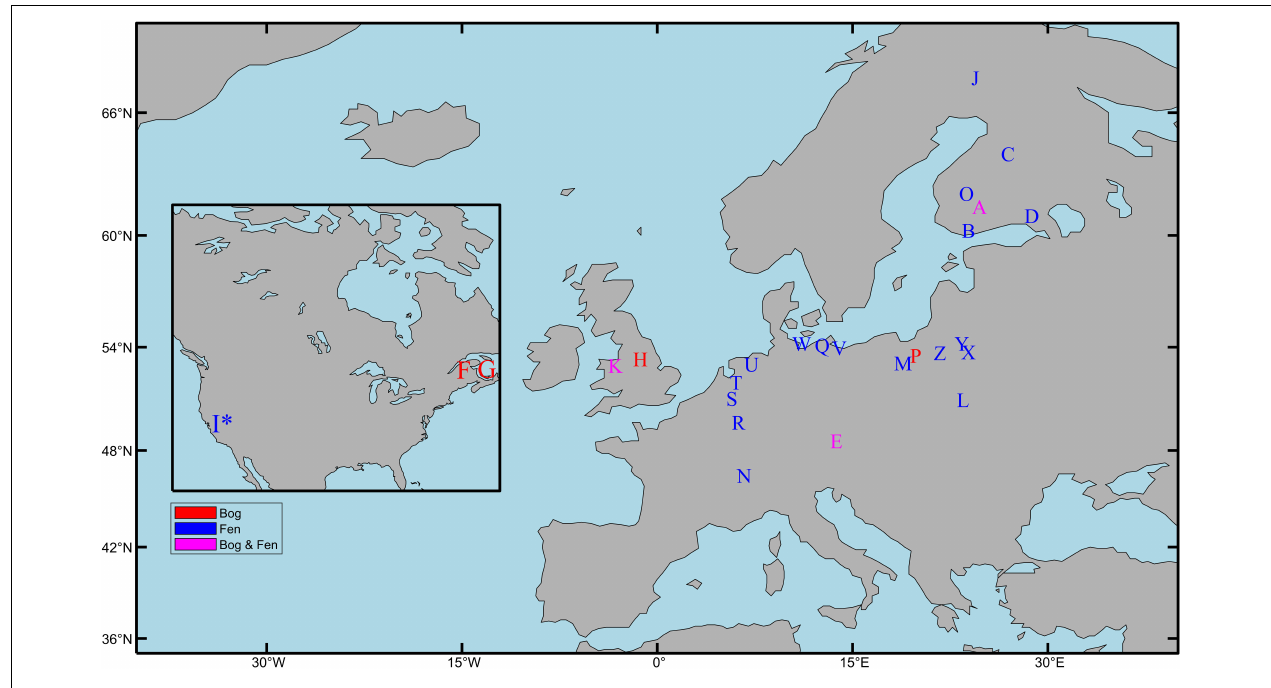
FIGURE 1 | Field locations used by studies investigating the response of microbial communities to peatland drainage and rewetting. See Table 1 for study description ( ∗ ) = Marsh. Map made using the M_map package in MATLAB (Pawlowicz,